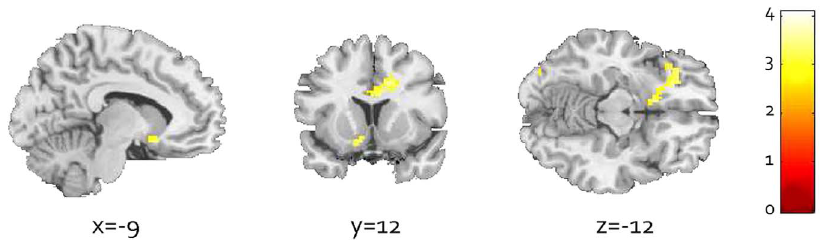
Figure 2. Cue-reactivity in AD patients compared with both comparison groups (D/A patients and HC). Two clusters are visible: Activation of a large cluster reaching from the OFC to the VS, and in the ACC . Colored bar: Z -scores from 0 to 4, P , 0.005, clustersize threshold . =15 voxels.